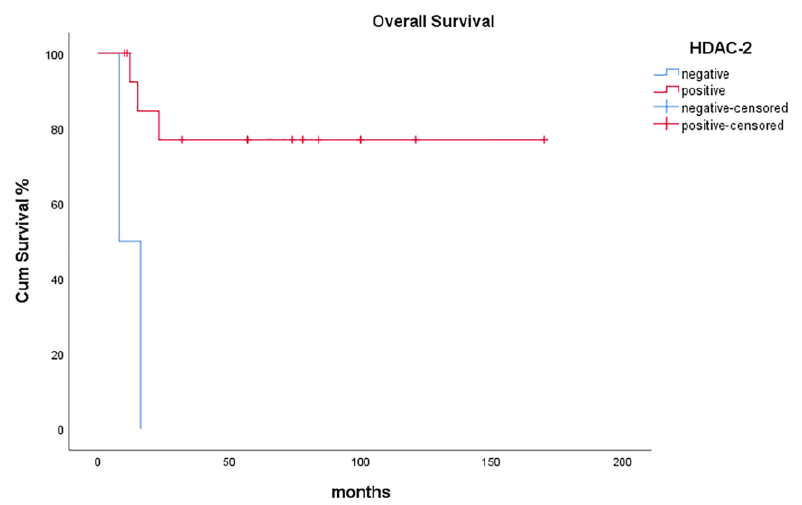
Figure 5. Kaplan-Meier survival analysis stratified according to HDAC-2 positivity in patients with HG malignant SGTs.